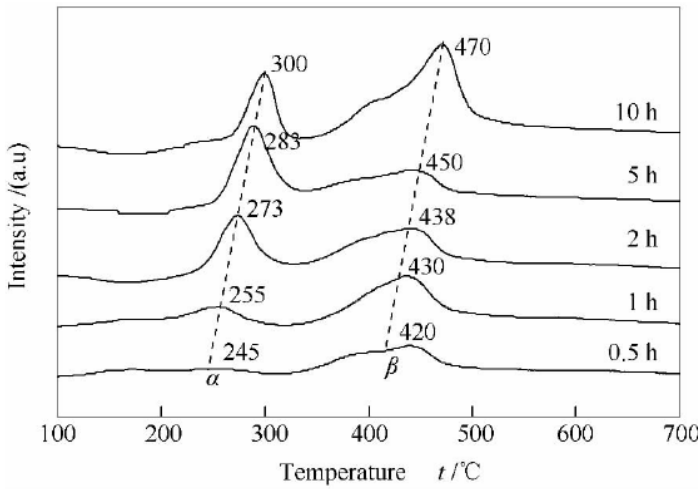
Figure 2. TPH profiles of various spent Ni-Al 2 O 3 catalysts after carrying out the CO 2 -CH 4 reforming reaction for different times [49].